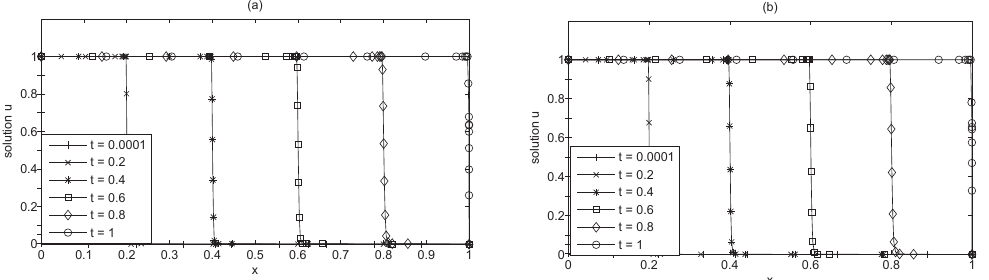
Figure 1. Numerical solutions of Advection-diffusion equation applying Huang’s method ( a ) and the proposed method ( b ), N = 21.